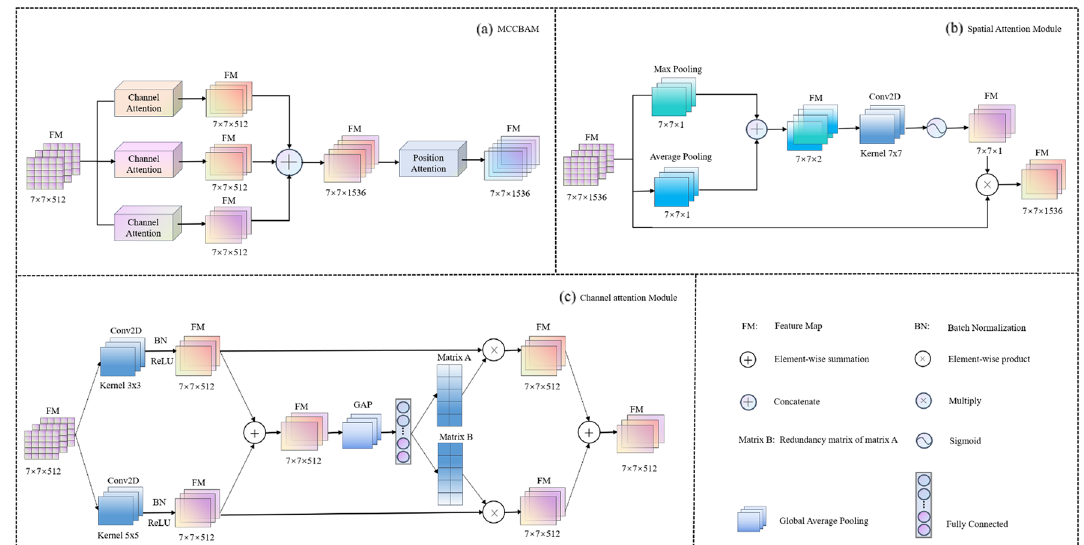
Figure 3. The framework of MCCBAM. ( a ) The overall architecture of MCCBAM. ( b ) Components of the Spatial Attention Block. ( c ) Components of the Channel Attention